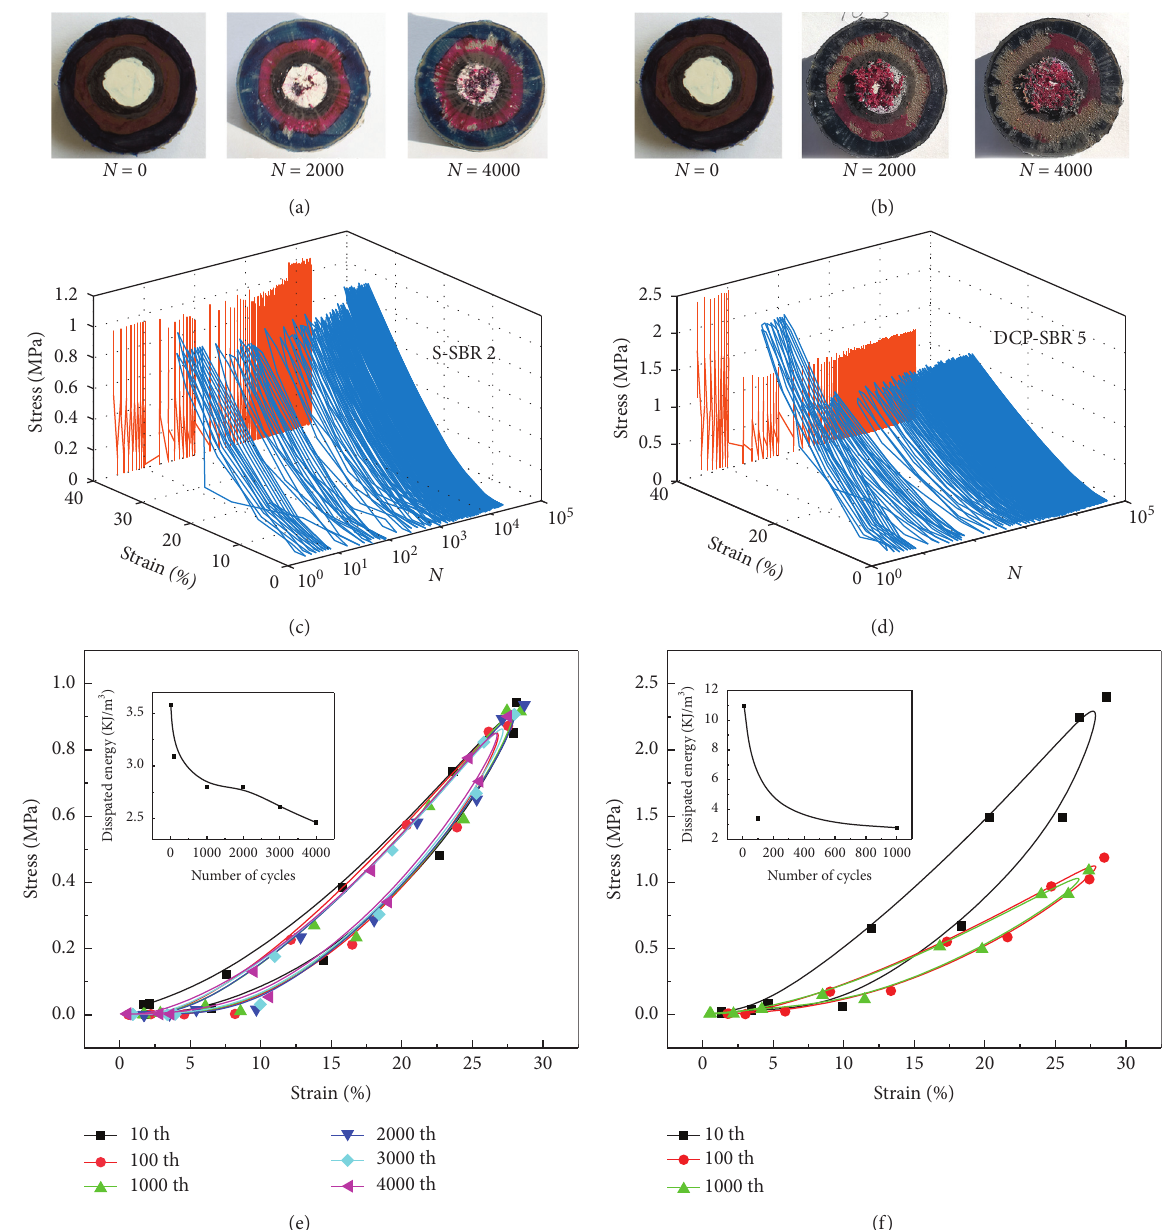
Figure 2: (a, b) Top view of damage surfaces of S-SBR 2 sample and DCP-SBR 5 sample after different compressive test cycles, (c, d) three- dimensional compressive stress-strain curves of two samples, and (e, f) stress-strain curves and corresponding dissipated energy of two samples during fatigue